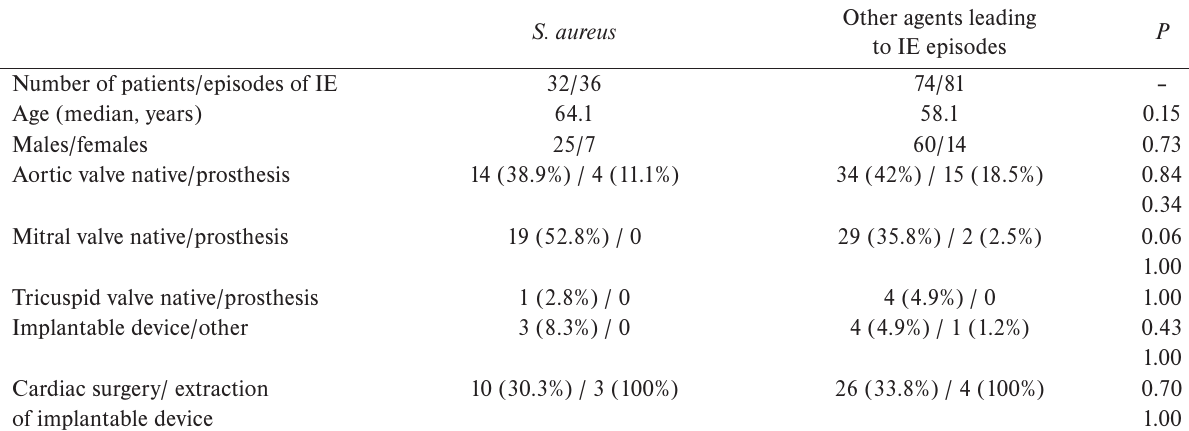
Table 1. Demographic data of IE episodes caused by S. aureus and other agents leading to IE episodes. S.